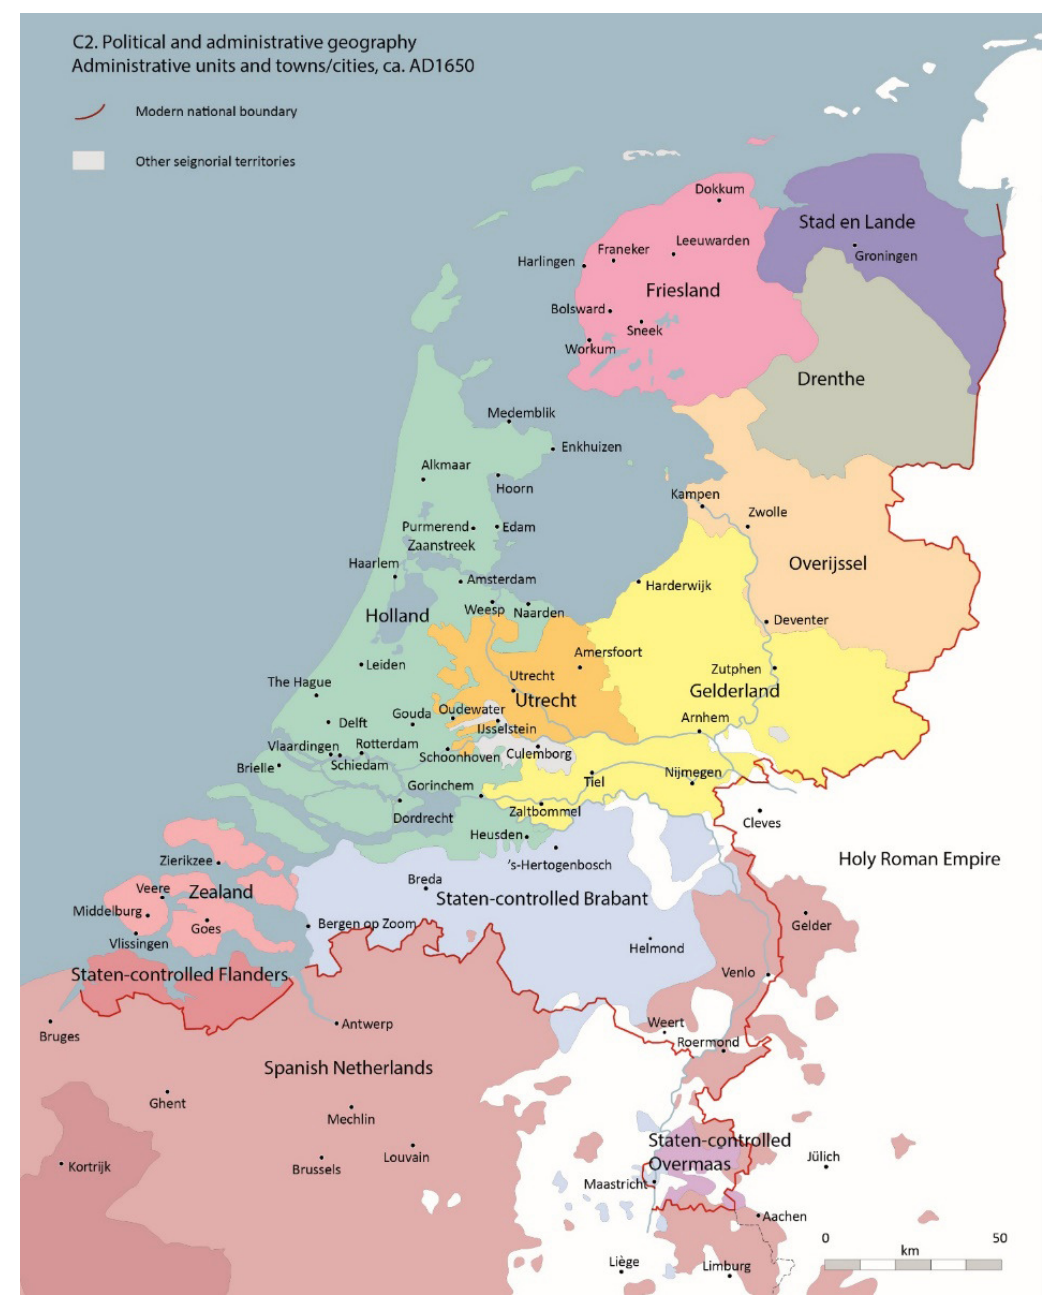
Figure 6. Political and administrative boundaries in the Netherlands, ca. 1650. Source: Rutte and Abrahamse (2016). citizenry in the fragmented area of the seven provinces of the Dutch Republic began to act with increasing inde‐ pendence while the economies of the cities in Holland flourished (Rutte & Abrahamse, 2016, pp.